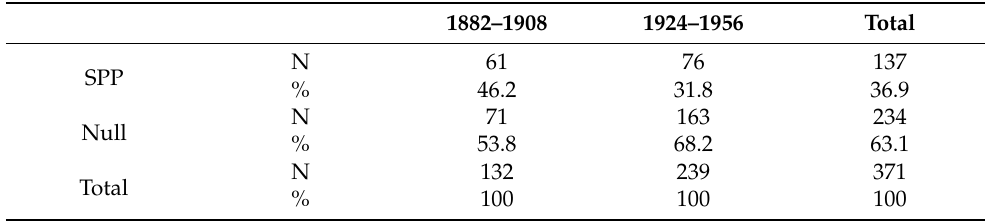
Table 8. Crosstabulation of first person singular verbs in switch reference contexts across time.